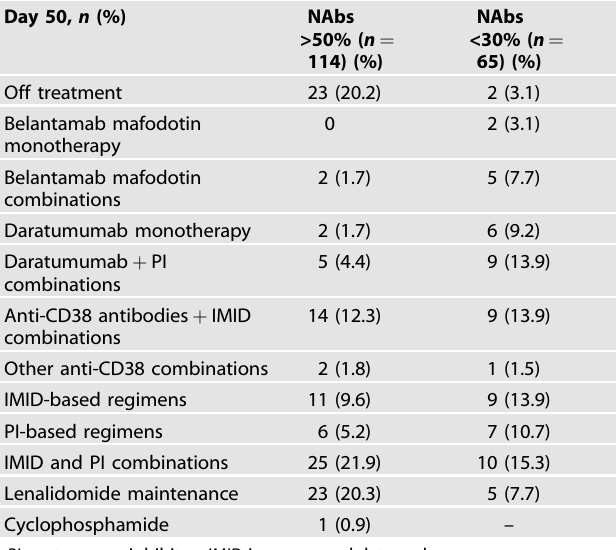
(Table 3). At this point, we need to stress that almost 85% of patients under daratumumab-based regimens were at the monthly administration schedule of daratumumab. We subsequently examined if there was any effect of the line of therapy (two versus more than two lines of therapy or three versus more than three lines) and there was no in fl uence of the line of therapy on the development of NAbs in all studied timepoints.